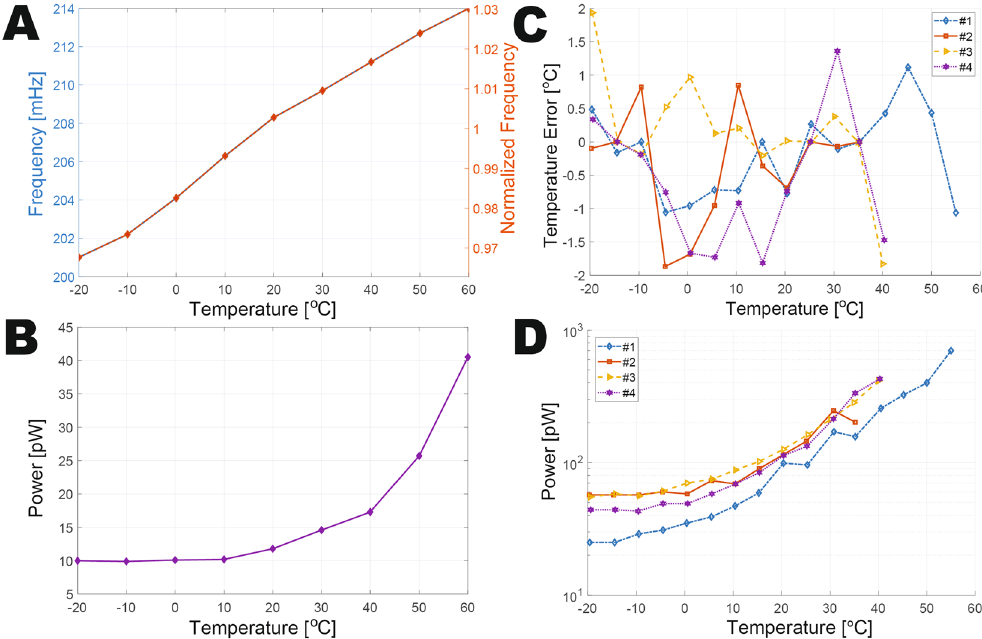
Figure 4. Experimental results of the intrinsic oscillator and temperature sensor. ( A ) Measured oscillation frequency of the intrinsic oscillator across temperature at V DD = 0.5 V. ( B ) Measured power of the intrinsic oscillator across temperature at V DD = 0.5 V. ( C ) Measured temperature error across temperature at V DD = 0.5 V. ( D ) Measured power of the temperature sensor across temperature at V DD = 0.5